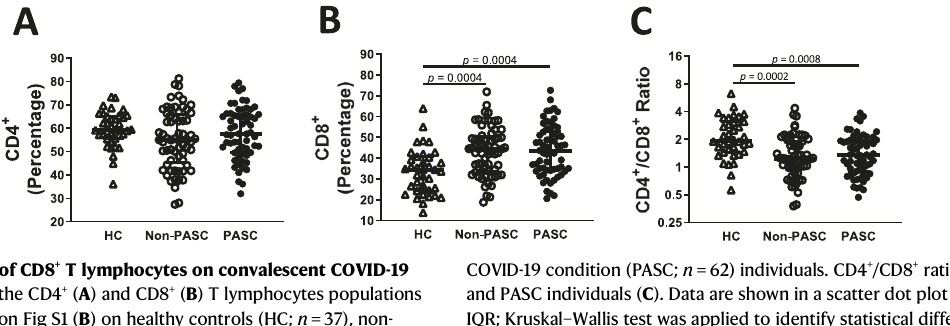
COVID-19 condition (PASC; n =62) individuals. CD4 + /CD8 + ratio on HC, non-PASC and PASC individuals ( C ). Data are shown in a scatter dot plot format as median ± IQR; Kruskal – Wallis test was applied to identify statistical differences followed by Dunn ’ s multiple comparisons